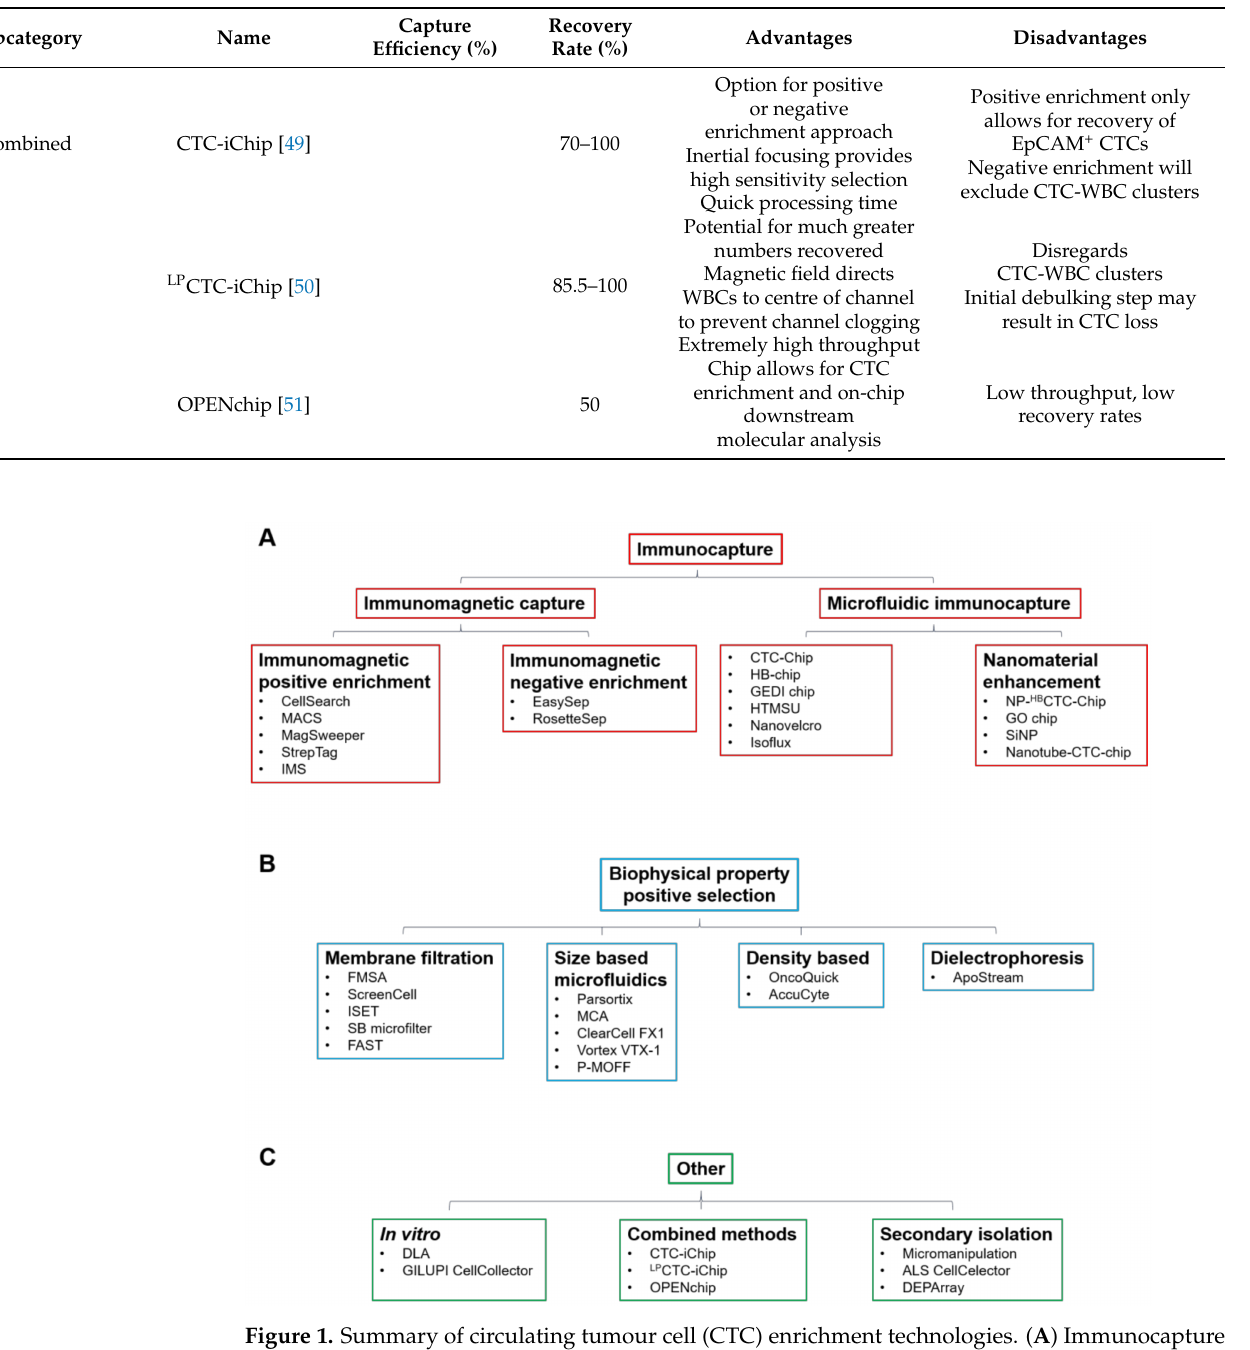
Figure 1. Summary of circulating tumour cell (CTC) enrichment technologies. ( A )